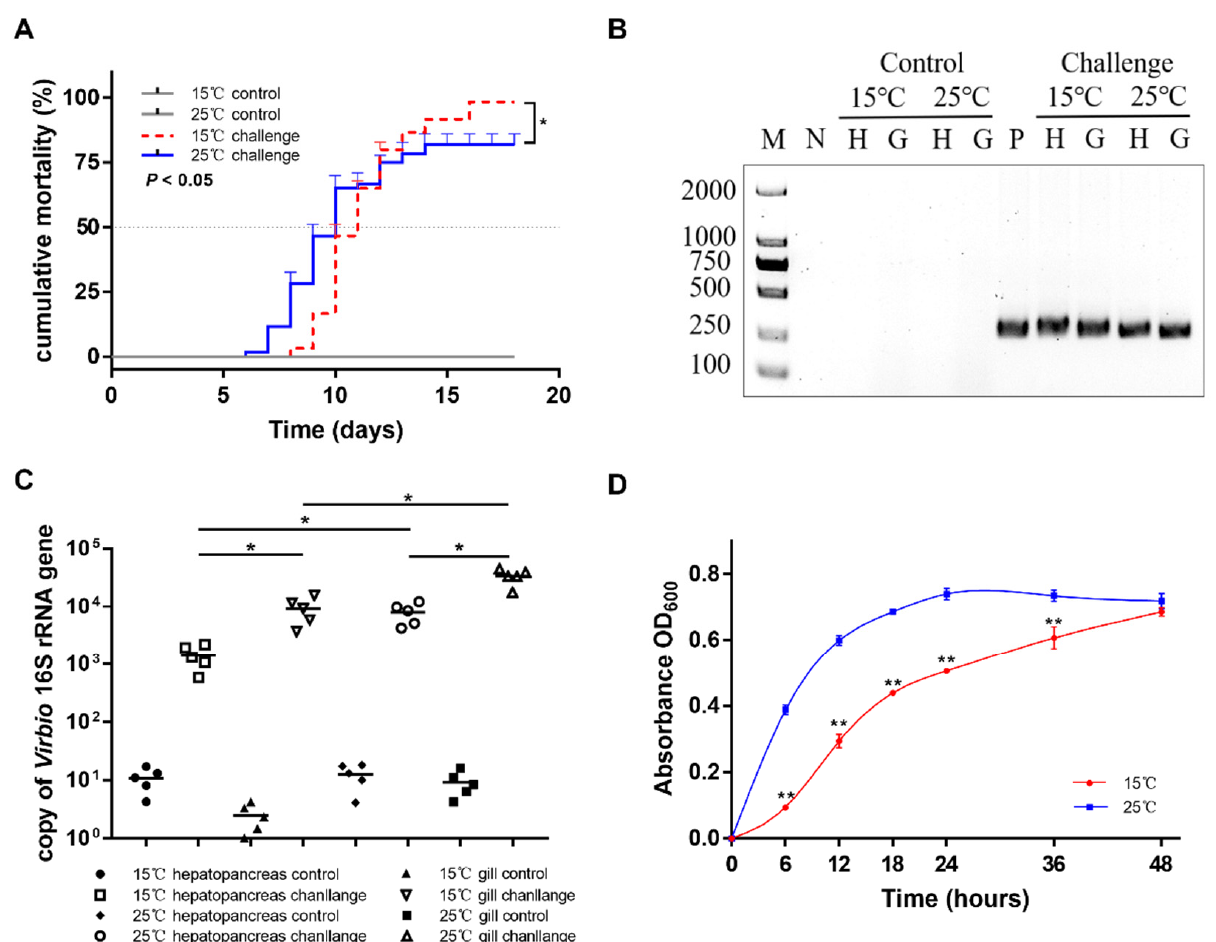
Figure 5. Pathogenicity of SbA1-1 to ark clams. ( A ) Cumulative mortality of ark clams challenged with SbA1-1. Ark clams in the challenge group were immersed in SbA1-1 (1 × 10 5 CFU/mL) at 15 ◦ C and 25 ◦ C. * p < 0.05. ( B ) Detection of challenged ark clams by V. kanaloae -specific nested PCR. M: molecular marker; N: negative control; P: positive control; H: hepatopancreas; G: gill. ( C ) The abundance of Vibrio in hepatopancreas and gill tissue after SbA1-1 infection in ark clams. ** p < 0.01; * p < 0.05. ( D ) Growth dynamics of SbA1-1. Growth was assayed in DPM medium by measuring OD 600 for 48 h at 15 ◦ C and 25 ◦ C. ** p < 0.01; * p < 0.05.